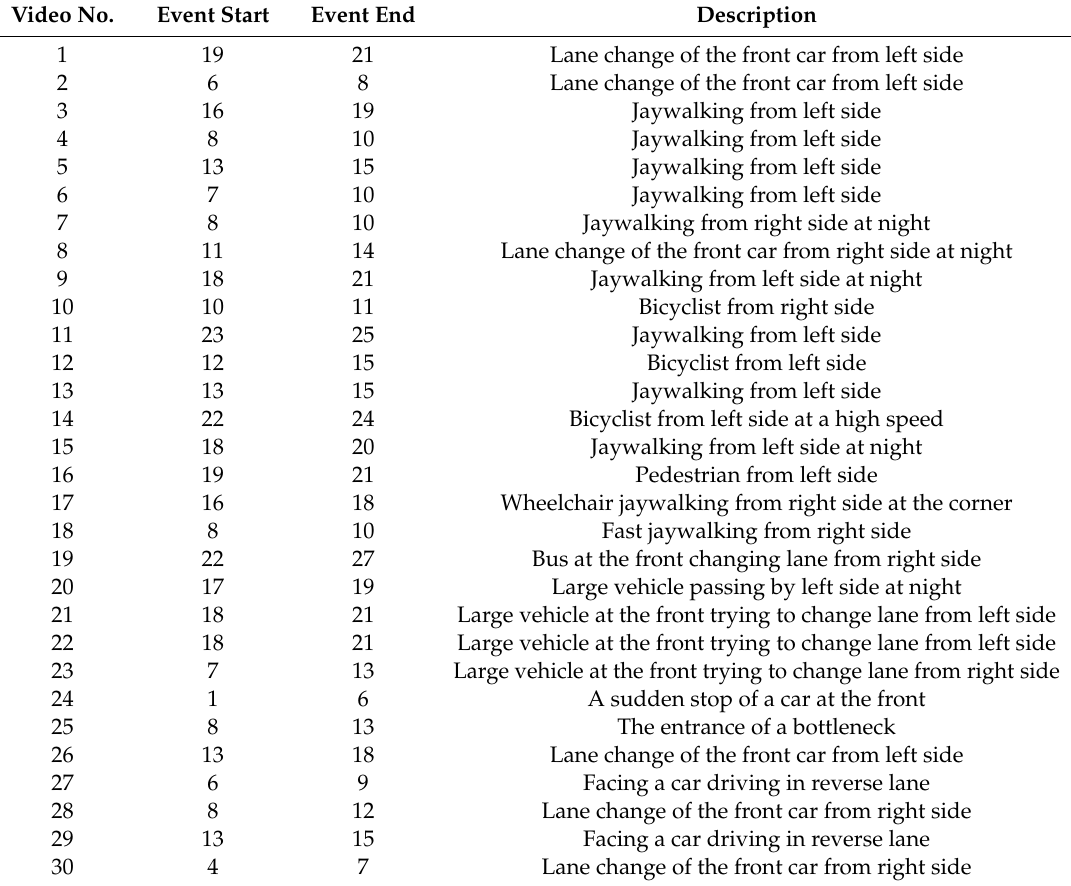
Table A1. Descriptions of video with anxiety